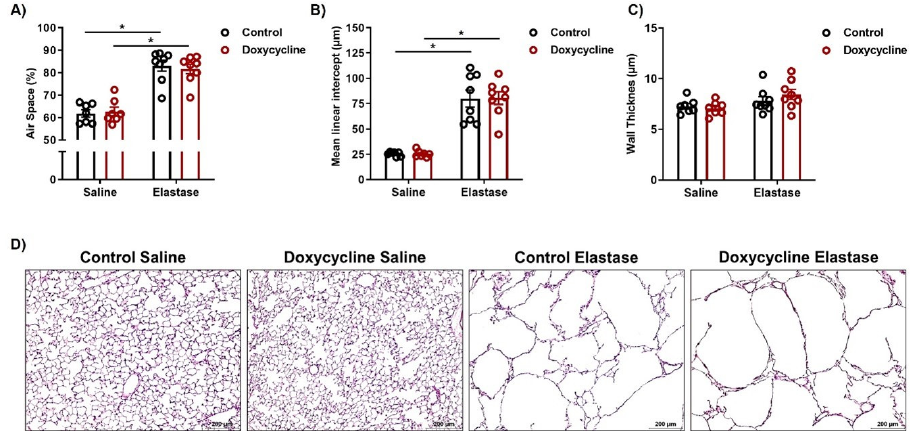
Figure 4. iNOS knockout in AECII cells does not influence regeneration of alveolar epithelium in mice with severe emphysema. ( A – C ) Alveolar morphometry ( n = 7–8) showing ( A ) the percentage of airspace, ( B ) septal wall thickness and ( C ) mean linear intercept in saline- or elastase-treated iNos CCSP rtTA2 s -M2 LC1 mice fed either with normal (control) or doxycycline-containing (Doxycycline) chow, after the 12-week follow-up observation period. Graphs show mean ± SEM. * p < 0.05. Two- way ANOVA (with Tukey´s multiple comparison post-hoc test) was used. ( D ) Representative images of lung sections from control and doxycycline-fed mice, 12 weeks after elastase instillation, stained with hematoxylin-eosin (H&E). Scale bar = 200 µm.